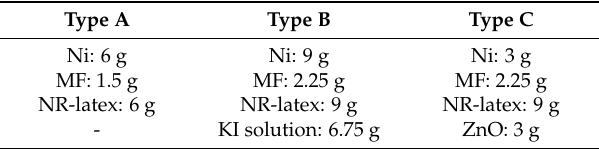
Table 1. Ingredients of the MCF rubber liquid used in this study.